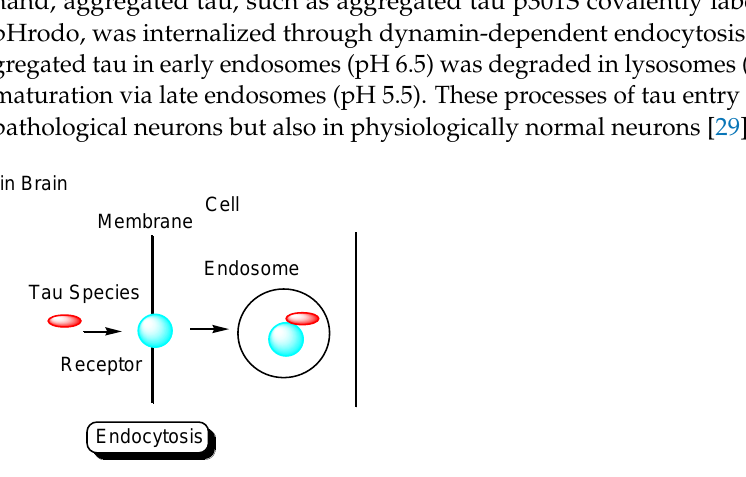
Figure 4. Tau species enter the cells based on endocytosis such as receptor-mediated endocytosis.